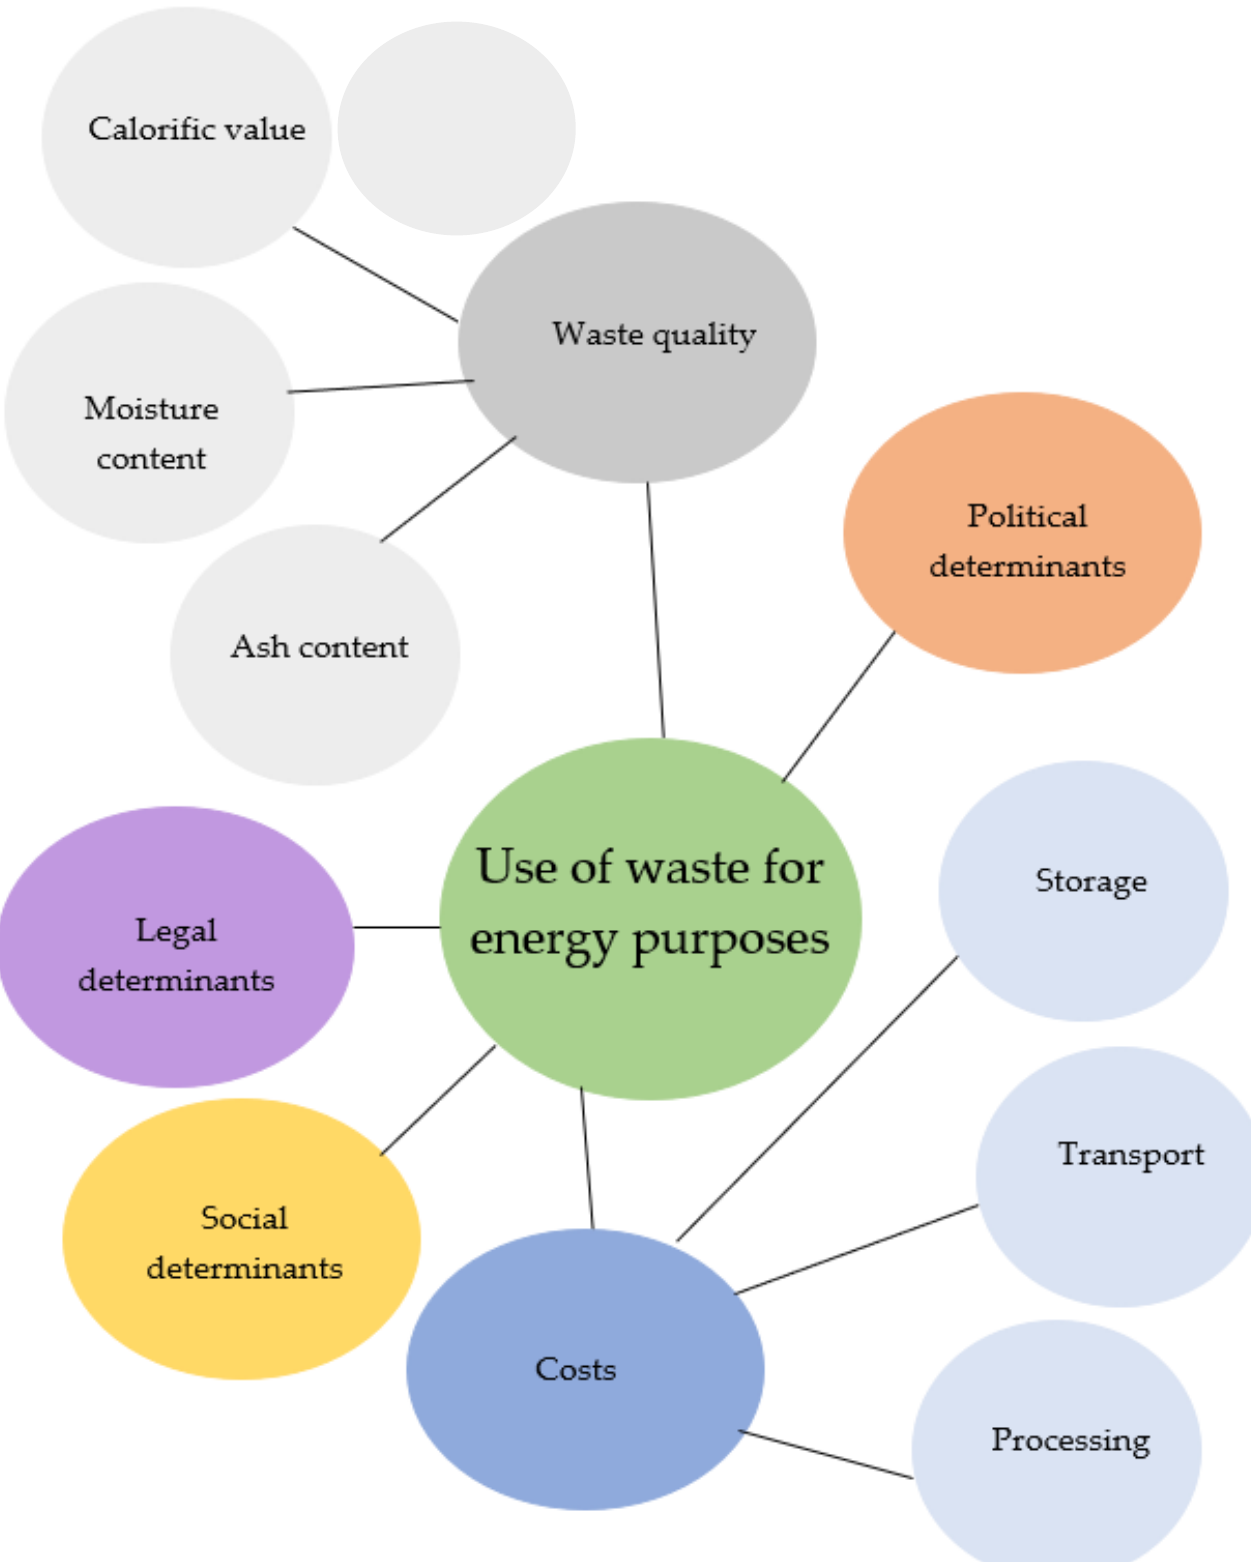
Figure 2. Determinants shaping the use of waste for energy purposes.